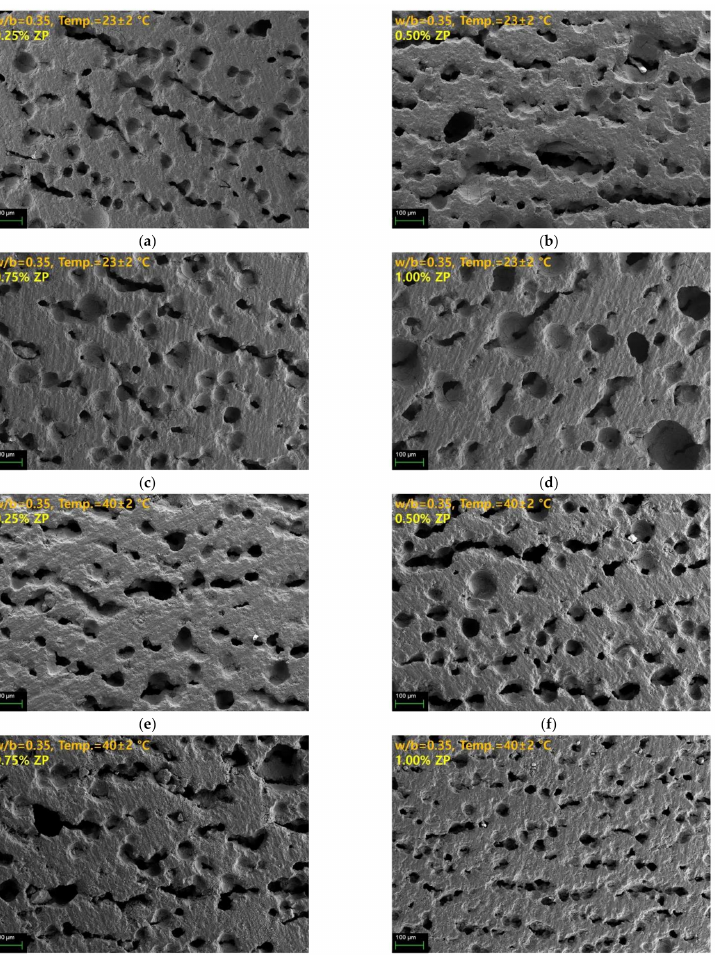
Figure 5. SEM images of samples with a w/b of 0.35 ( a ) cured at 23 ± 2 ◦ C, 0.25% ZP, ( b ) cured at 23 ± 2 ◦ C, 0.50% ZP, ( c ) cured at 23 ± 2 ◦ C, 0.75% ZP, ( d ) cured at 23 ± 2 ◦ C, 1.00% ZP, ( e ) cured at 40 ± 2 ◦ C, 0.25% ZP, ( f ) cured at 40 ± 2 ◦ C, 0.50% ZP, ( g ) cured at 40 ± 2 ◦ C, 0.75% ZP, and ( h ) cured at 40 ± 2 ◦ C, 1.00%